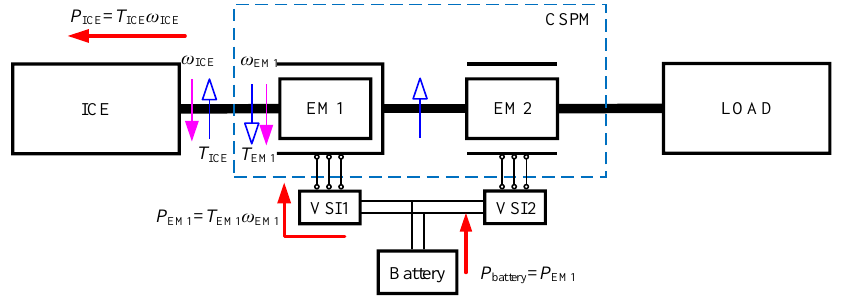
Figure 4. Starter mode and the related power flow diagram.